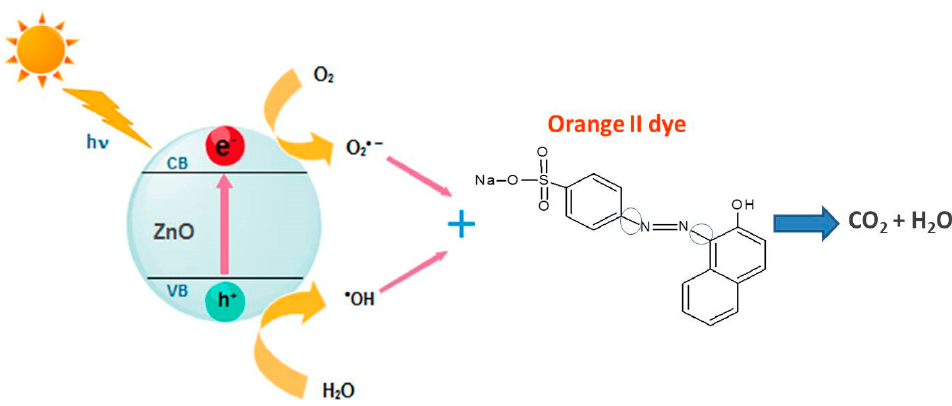
Figure 8. Mechanism of photocatalytic degradation of orange II dye by ZnO nanorods.